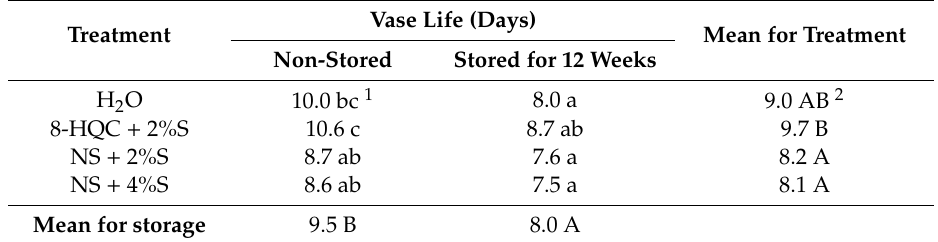
Figure 1. The effect of 12 weeks storage and application of holding solutions after storage, on the appearance of cut ‘Sarah Bernhardt’ flowers after 8 days of vase life. 1 = water; 2 = 8-HQC + 2%S; 3 = NS + 2%S; 4 = NS + 4%S. Table1. Thee ff ectofholdingsolutionsandstorageonthevaselifeofcutpeony‘SarahBernhardt’flowers. Vase Life (Days) Treatment